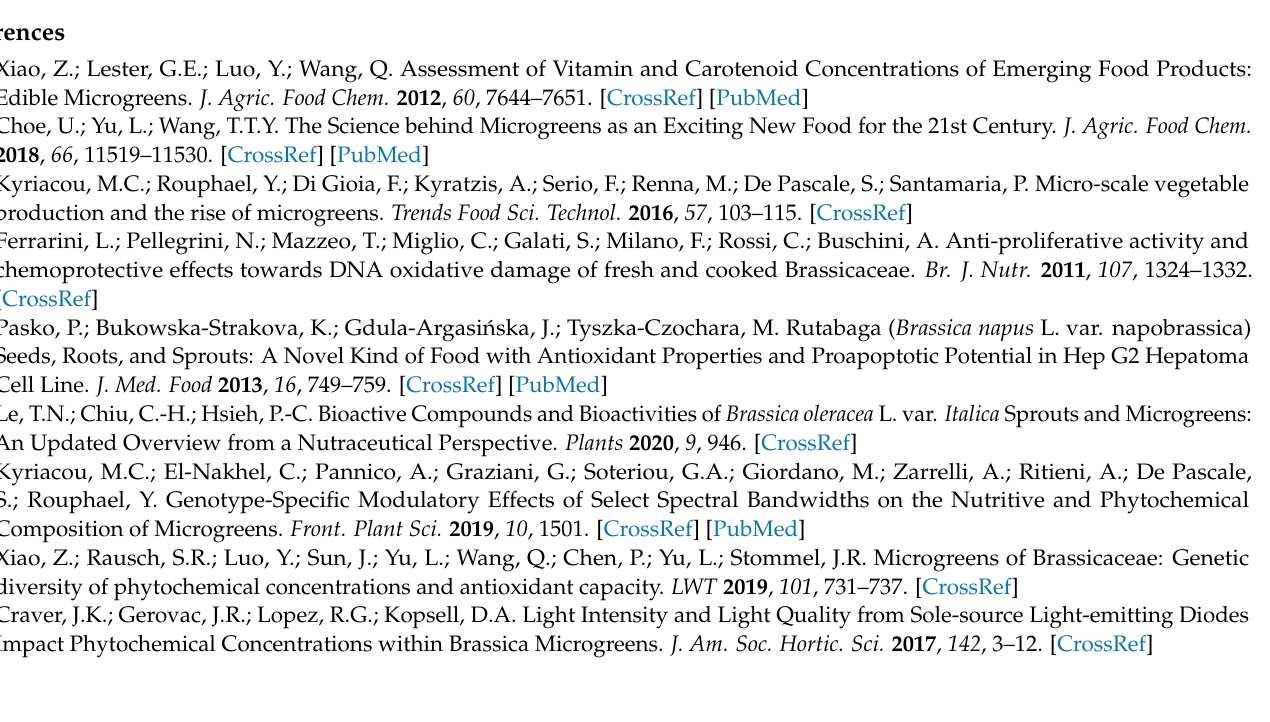
treatments, Figure S2: Growth and morphology of RD-ES spheroids, Table S1: Spheroid area and diameter of RD-ES